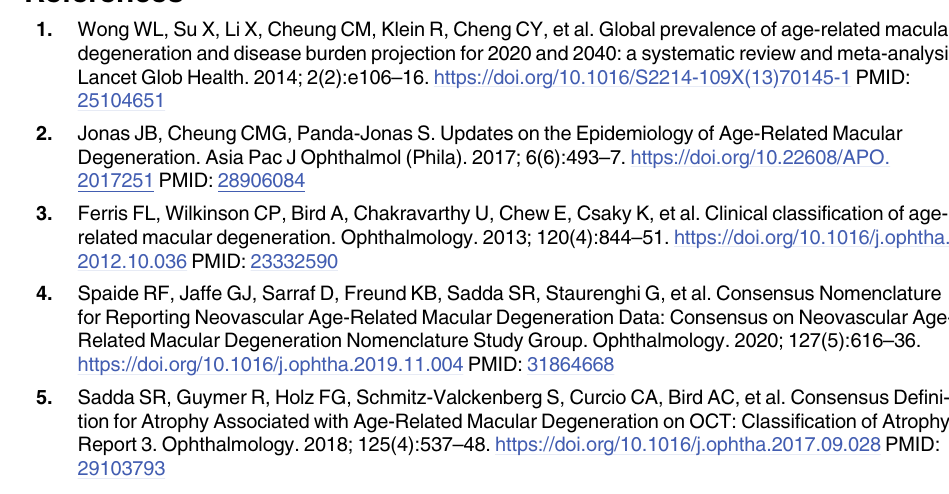
S3 Fig. Bar plot depicting performances of 2-year predicting models with and without fel- low eye status as a predictor. S4 Fig. Performance of models built for diagnosis of wet AMD expanded with the AMD status of the fellow eye. S5 Fig. Prediction of exudative AMD Conversion. For every week on the x-axis a separate model was trained and evaluated on for the corresponding time frame. Left . Area under the ROC curve (AUROC) as a function of prediction time frame. Right . Area under the Precision- Recall curve (AUPRC) as a function of prediction time frame. 95% Confidence intervals were computed using